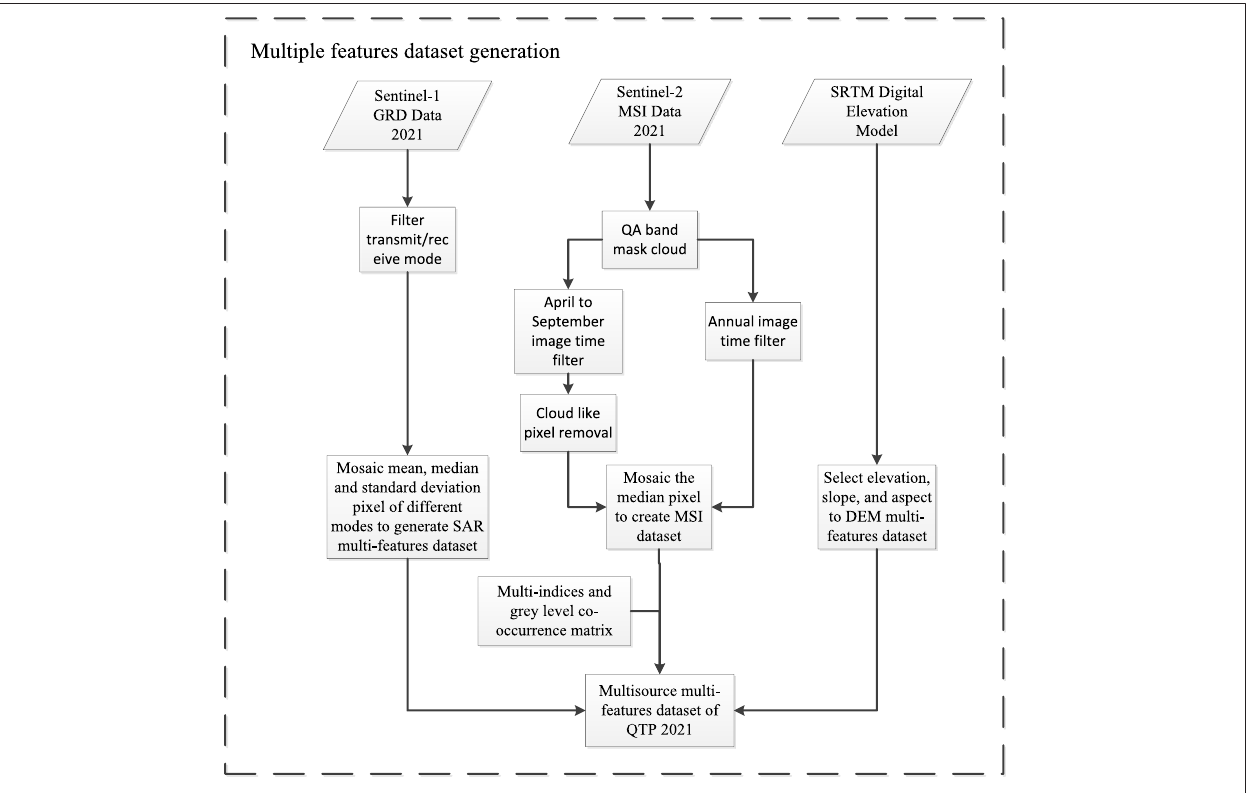
FIGURE 3 | Flowchart of multiple feature dataset